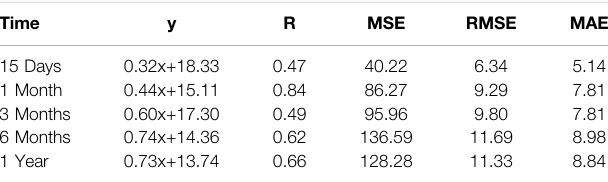
TABLE 6 | O 3 2020 model performance statistics with different time period in Jiangsu Province. Time y R MSE